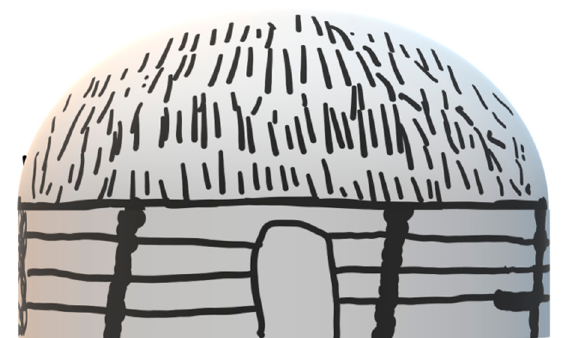
Figure 6. Illustration of Navajo winter hooghan.